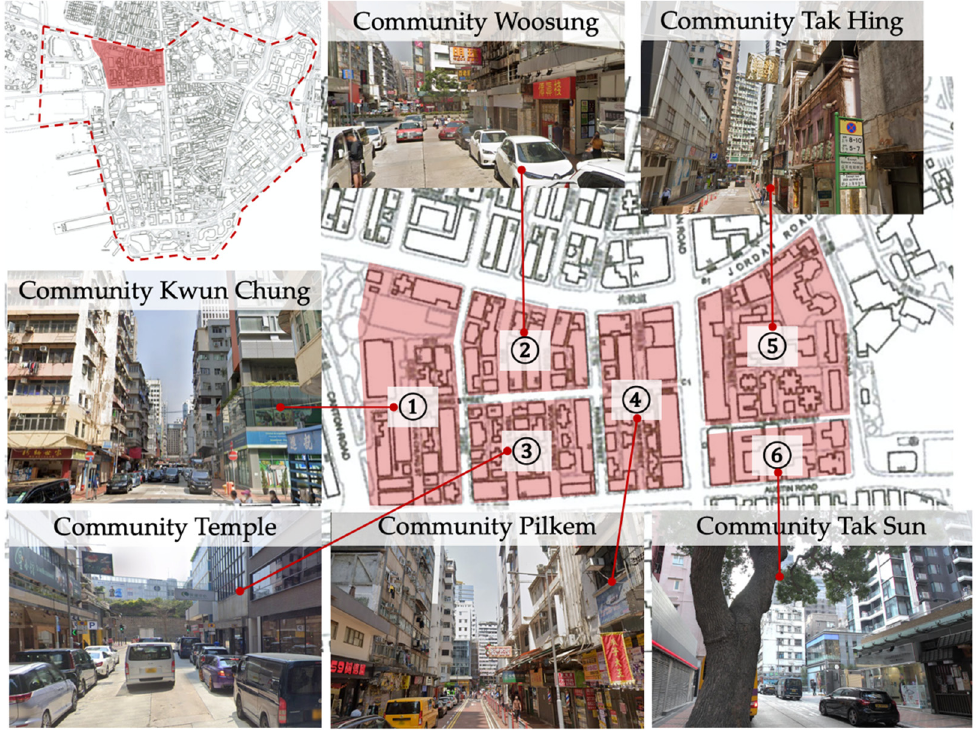
Figure 2. Target communities and streetscapes.